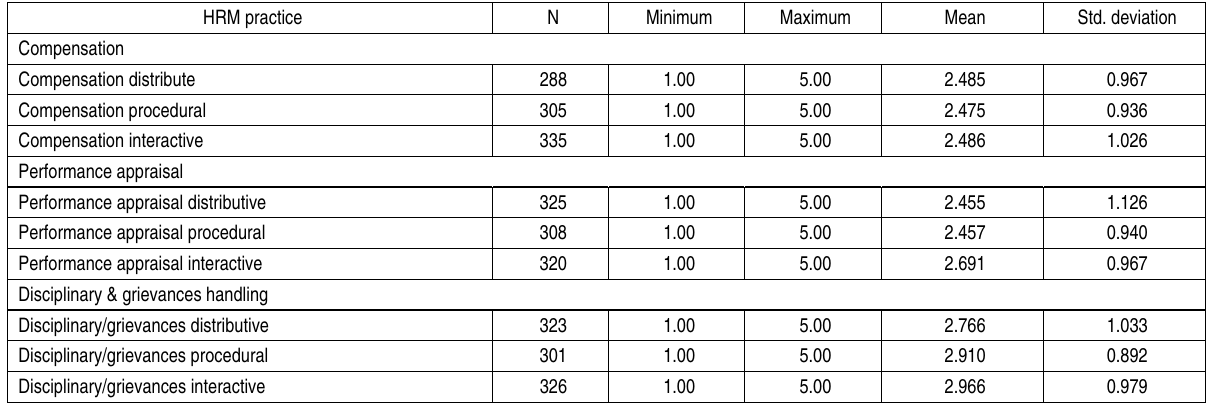
Table 1. Summary statistics for HRM